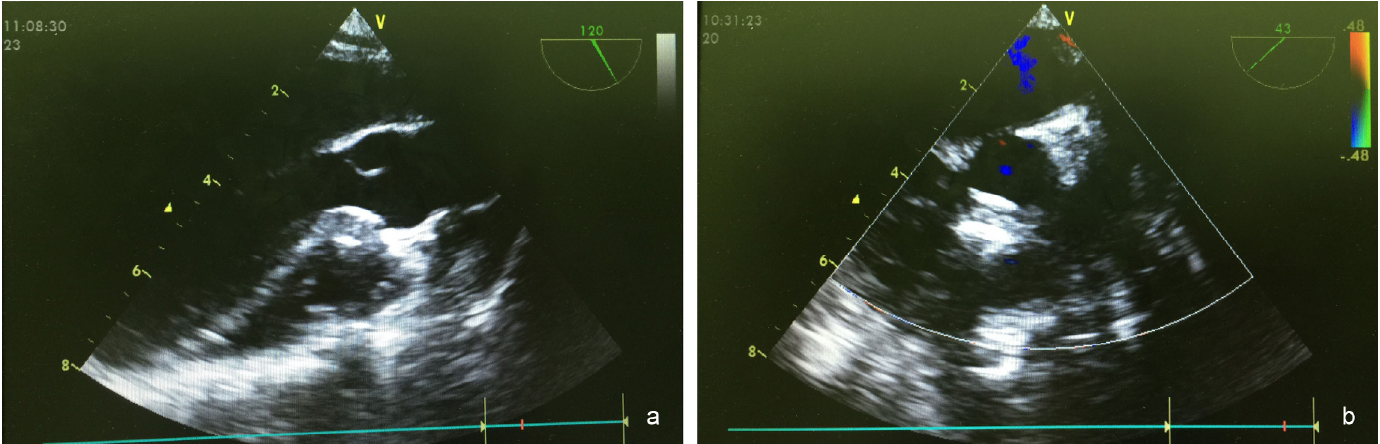
Fig. 2 - Transesophageal echocardiography after the procedure. A: long axis 2D view of the device. B: short axis of the device with color Doppler.